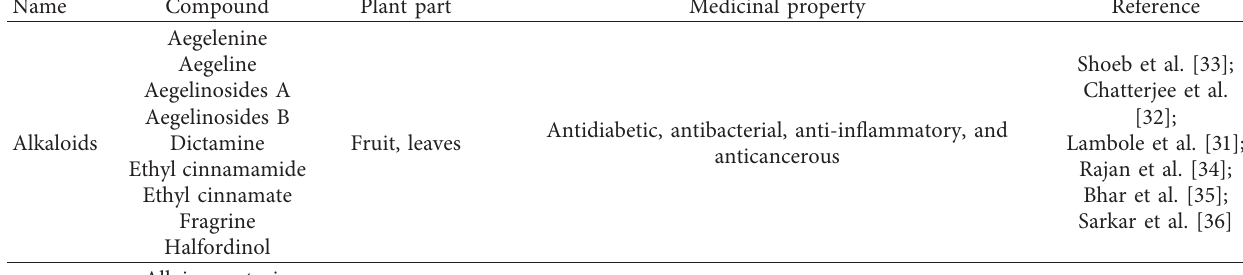
Table 2: A set of important phytochemicals in